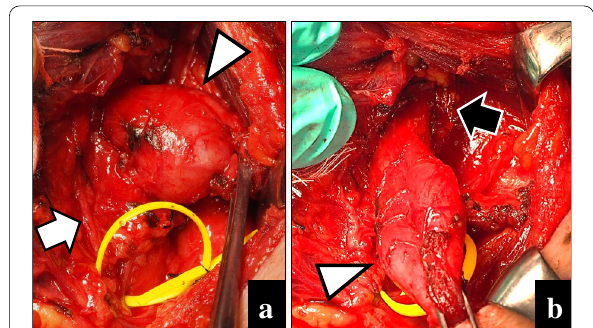
Fig. 2 Intraoperative photographs before and after diverticulectomy. a A diverticulum (arrowhead) with a defective area on the muscular layer, and the area of the left recurrent laryngeal nerve (white arrow). b Intraoperative anatomical relationship between the diverticulum (arrowhead) and cricopharyngeal muscle (black arrow) after partial